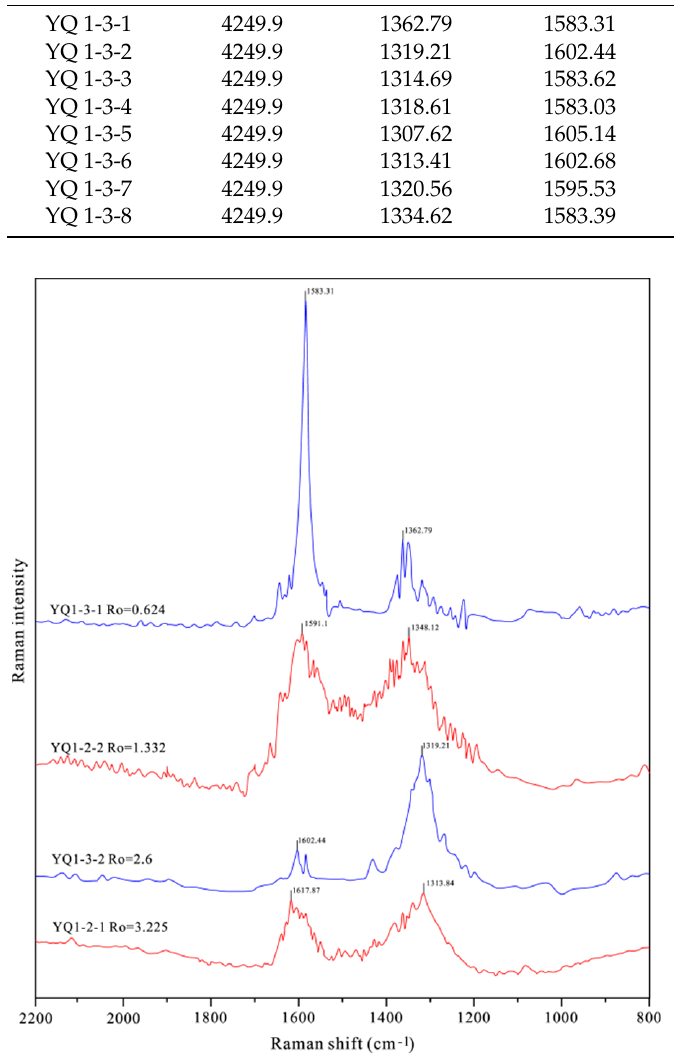
Figure 6. LRS of reservoir bitumen in Qingshuiying Formation in Well YQ-1. Red line: sampling depth is 4248.45 m; Blue line: sampling depth is 4249.9 m. Table 2. Laser Raman results of reservoir bitumen.